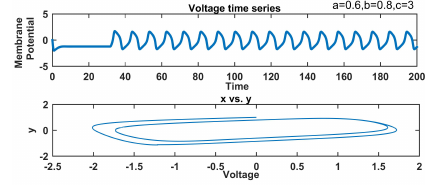
Figure 36. Responses of membrane potential and recovery variables with a = 0.6, b = 0.8, c = 3